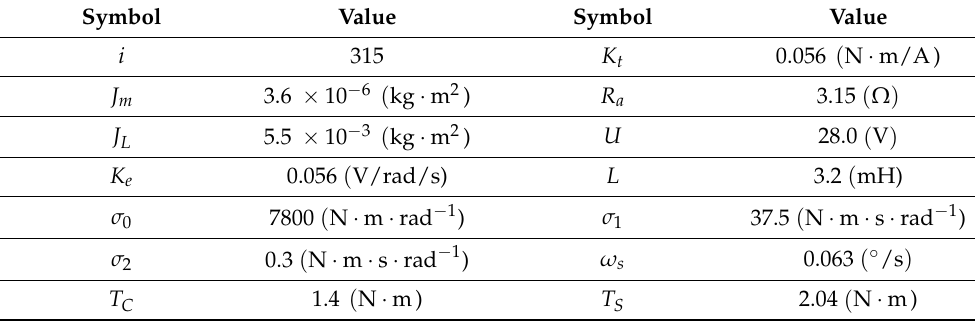
Table 1. EMA parameters.